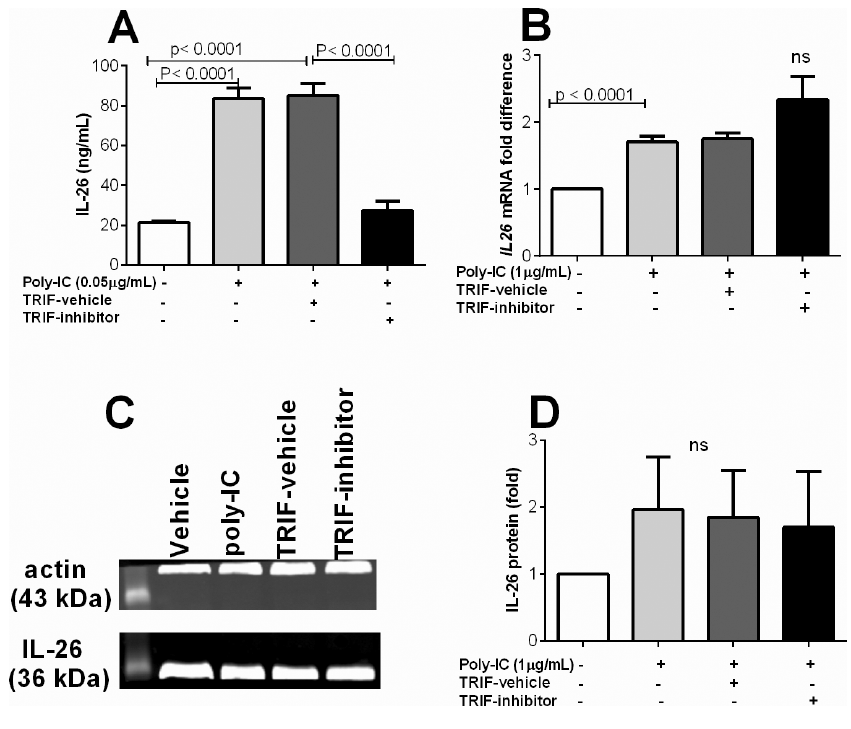
Figure 2. The adaptor protein TRIF is involved in poly-IC-induced release of IL-26. Pri- mary bronchial epithelial cells were preincubated (5 h) with TRIF inhibitor and vehicle (25 μmol/L). Extracellular concentrations of IL-26 in cell-free conditioned media as well as intracellular levels were measured using ELISA and western blot respectively and mRNA levels using real time. (A) Extracellular concentrations of IL-26 in cell-free conditioned in response to poly-IC (0.05 μg/mL) in the presence of the TRIF inhibitor (n = 7). (B) Level of IL26 mRNA in response to poly-IC (1μg/mL) in the presence of the TRIF inhibitor (n = 8). (C) Intracellular IL-26 protein (representative western blot) and (D) the average protein expression (fold difference) in response to poly-IC (1 μg/mL) in the presence of the TRIF inhibitor (n =